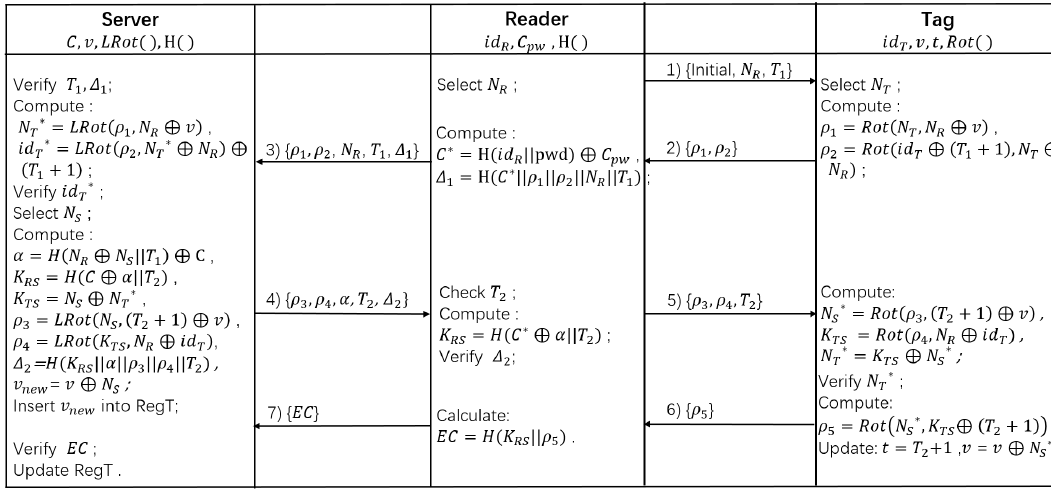
Figure 3. The authenticated